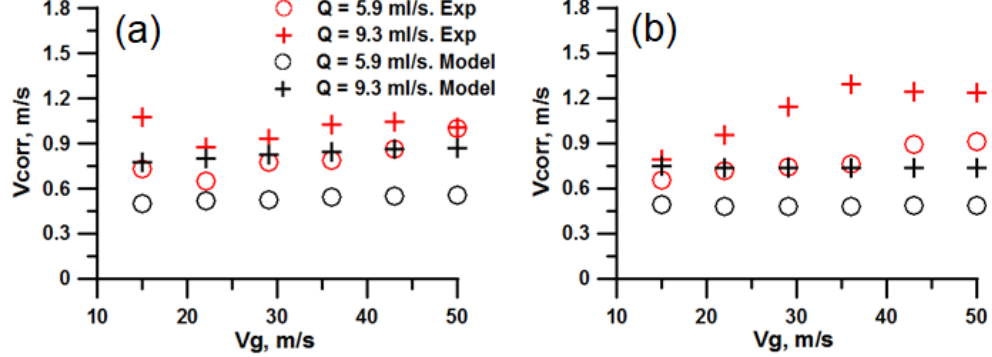
Figure 11. Comparison of the measured against the calculated increment of amplitude growth: ( a ) water; and ( b ) WGS2. On the quantitative level, the modeled and experimental values are of the same order of magnitude, but the discrepancy is significant. Modeled frequency shows good agreement to the measured one for the lowest liquid flow rate for water; for the larger flow rates, the model overestimates the measurement results (Figure 9a). Based on this observation, it was supposed in [29] that the model works well for low liquid flow rates. However, for different liquid viscosity, the model